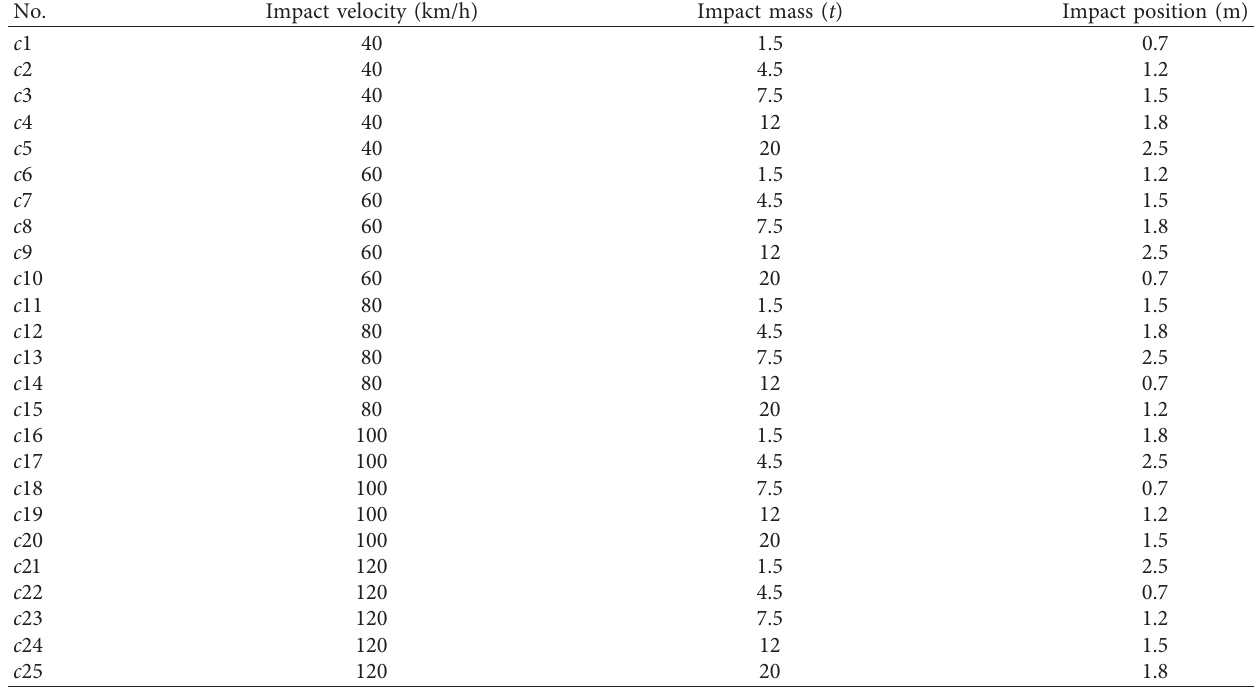
Table 2: Summary of research on transverse impact tests.